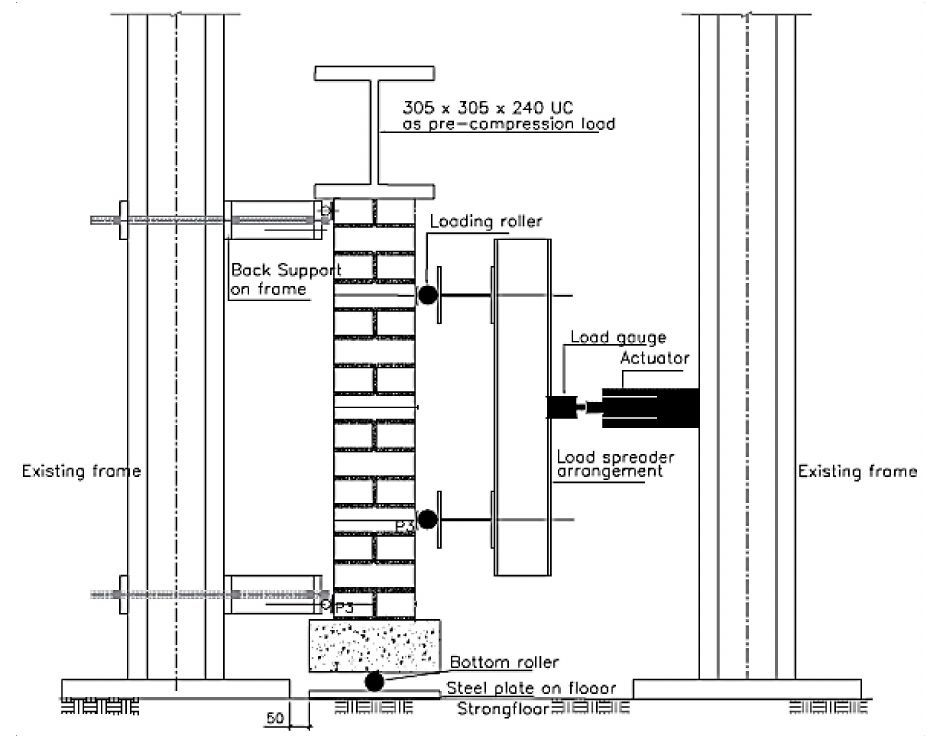
Figure 9. Large-scale test